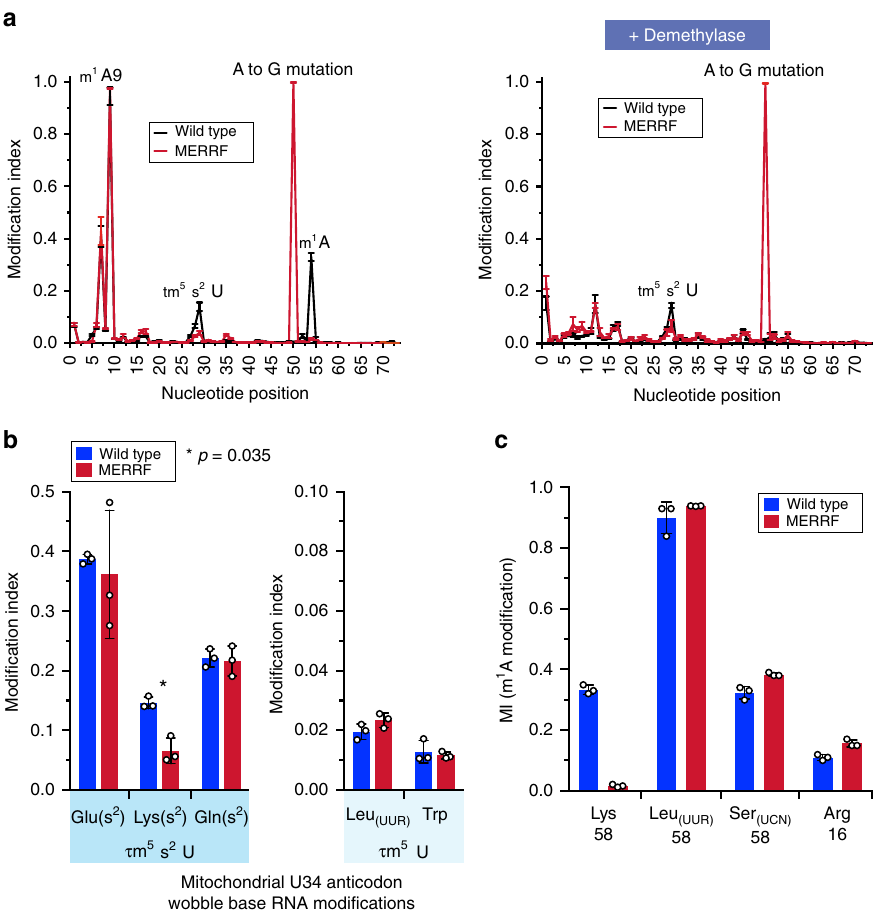
Fig. 2 Absence of an m 1 A modi fi cation in the m.8344 A > G tRNA Lys . a Position sequencing plots of tRNA Lys from human myoblasts homoplasmic for wild- type or the m.8344 A > G MERRF mutation without (left) and with (right) demethylase treatment. M 1 A9 produces two peaks, the fi rst corresponds to RT stop and mutations upon copying the m 1 A nucleotide and the second stop was due to m 1 A9 present in the RT template. b Quantitative comparisons of U34 anticodon wobble base modi fi cations in mitochondrial tRNAs from human myoblasts. Data represent mean + / − S.D. ( n = 3). Paired sample t test. c Quanti fi cation of m 1 A modi fi cations at the indicated positions in mitochondrial tRNAs from human myoblasts. Data represent mean + / − S.D. ( n =